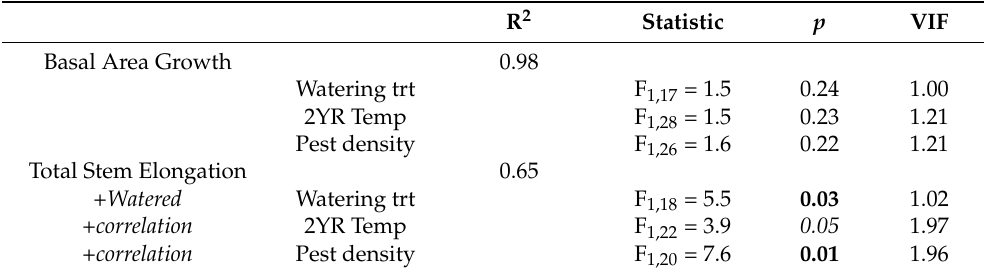
Table 3. Multiple linear regression with two-year mean tree canopy temperature, M. tenebricosa density, and watering treatment predicting basal area growth and total stem elongation per tree over two years. Interactions were not significant, so they were removed from each model. Bolded p -values are significant ( p < 0.05), and italicized p -values are nearly significant ( p < 0.1).